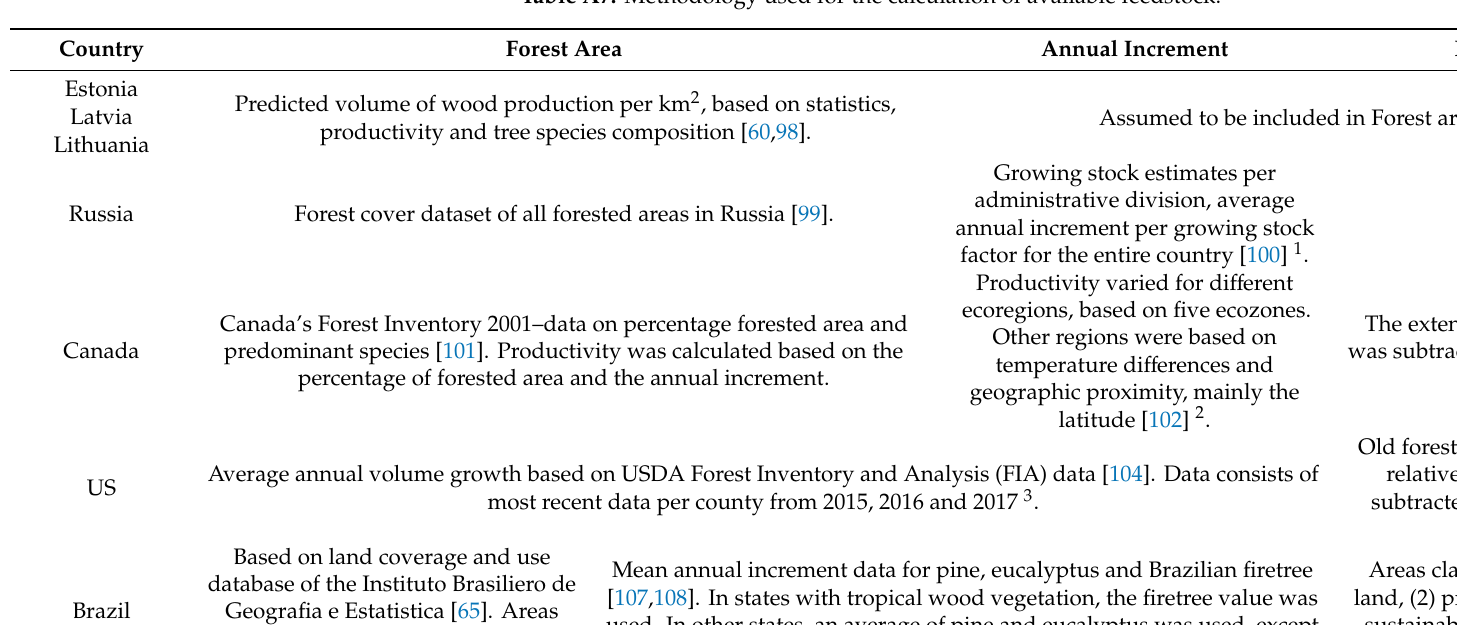
Table A7. Methodology used for the calculation of available